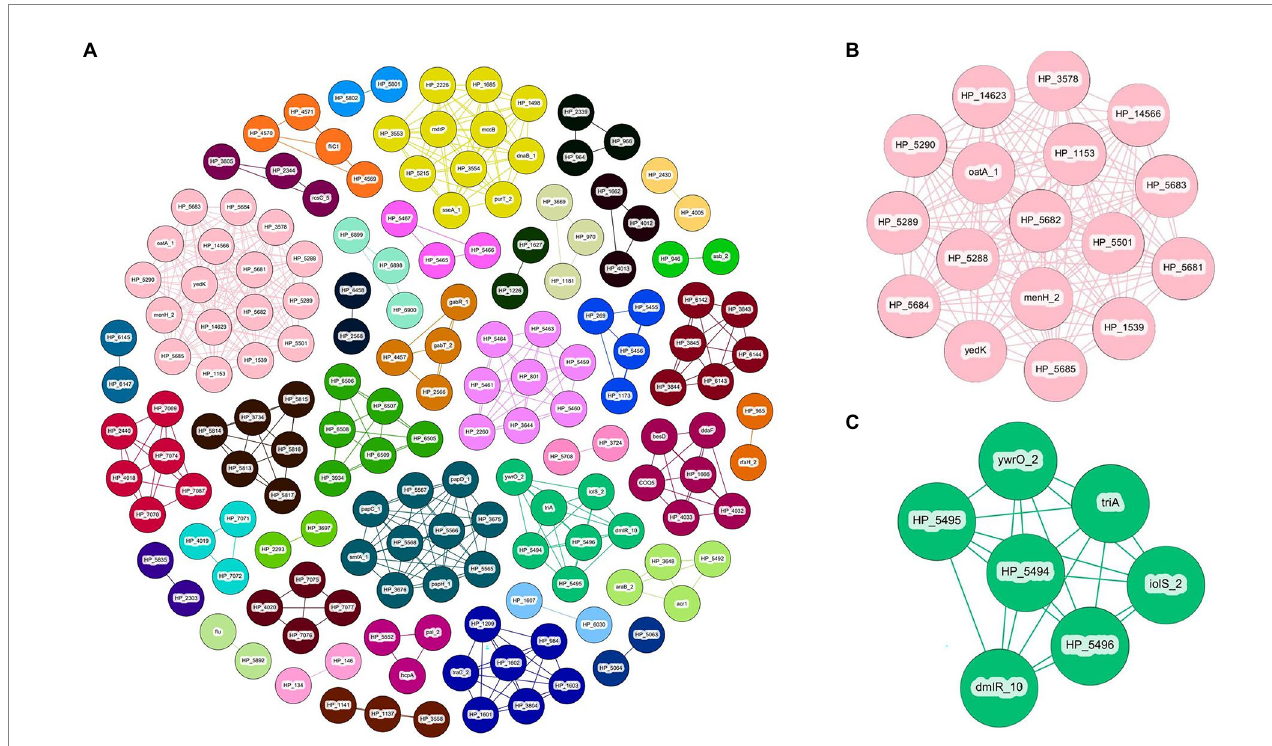
FIGURE 5 Coinfinder derived association of gene pairs from Pantoea ananatis genomes ( N = 92) displaying various networks (A) . Gene-pair association networks for components 31 (B) and 11 (C) are extracted due to their association with foliar pathogenicity for A. fistulosum × A. cepa. Gephi was used to apply the Fruchtermann Reingold layout to the network (https://gephi.org/). For all node labels, “group_” was replaced by “HP_” (hypothetical protein) for